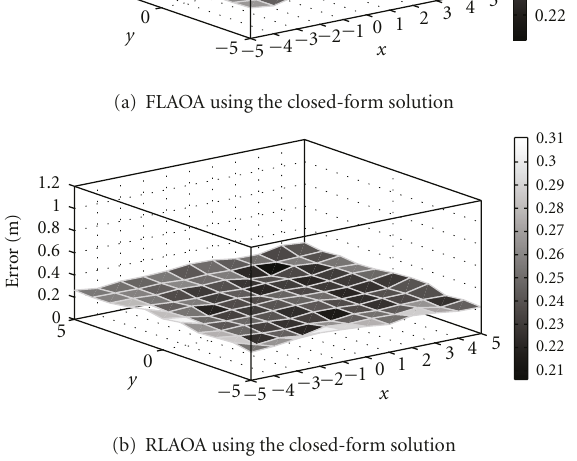
Figure 4: Number of divergence in the GN method.